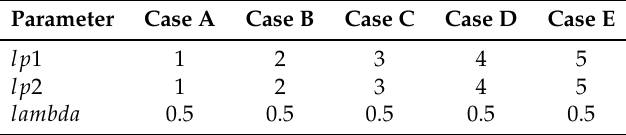
Table 3. African buffalo optimization metaheuristic parameters.